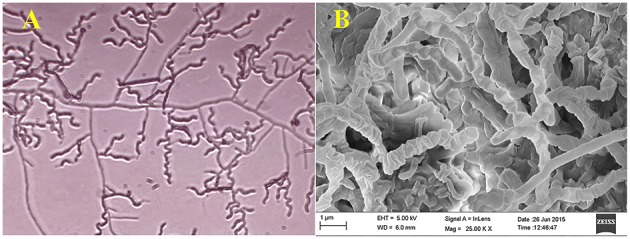
Microscopic view showing spore chain of Nocardia sp. PB-52 on GLM agar (A) Micro morphology using cover slip insertion method; (B) Scanning electron micrograph view.